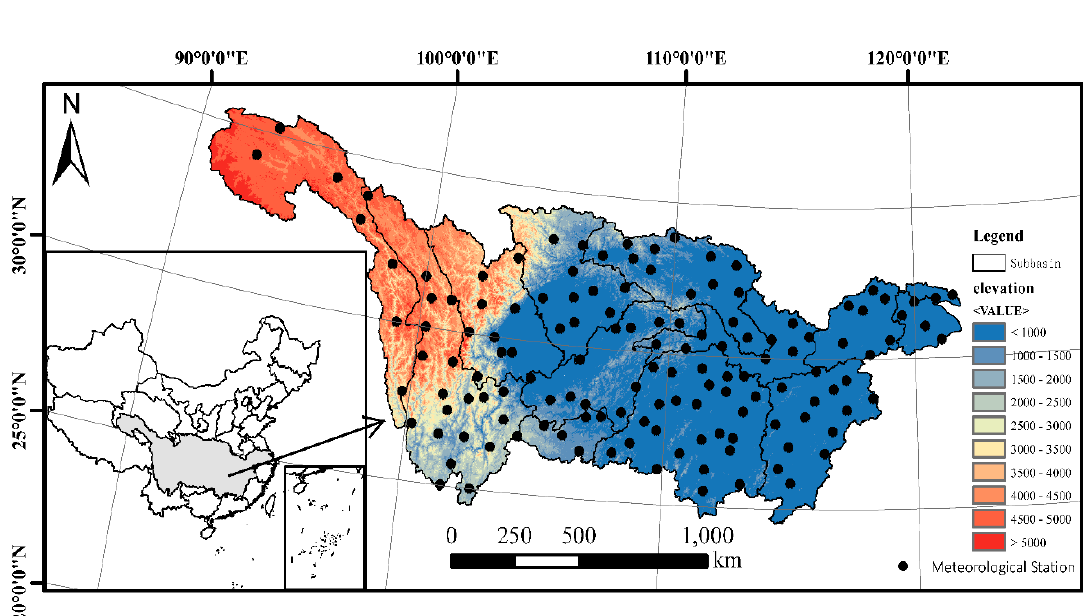
Figure 1. The Yangtze River basin.